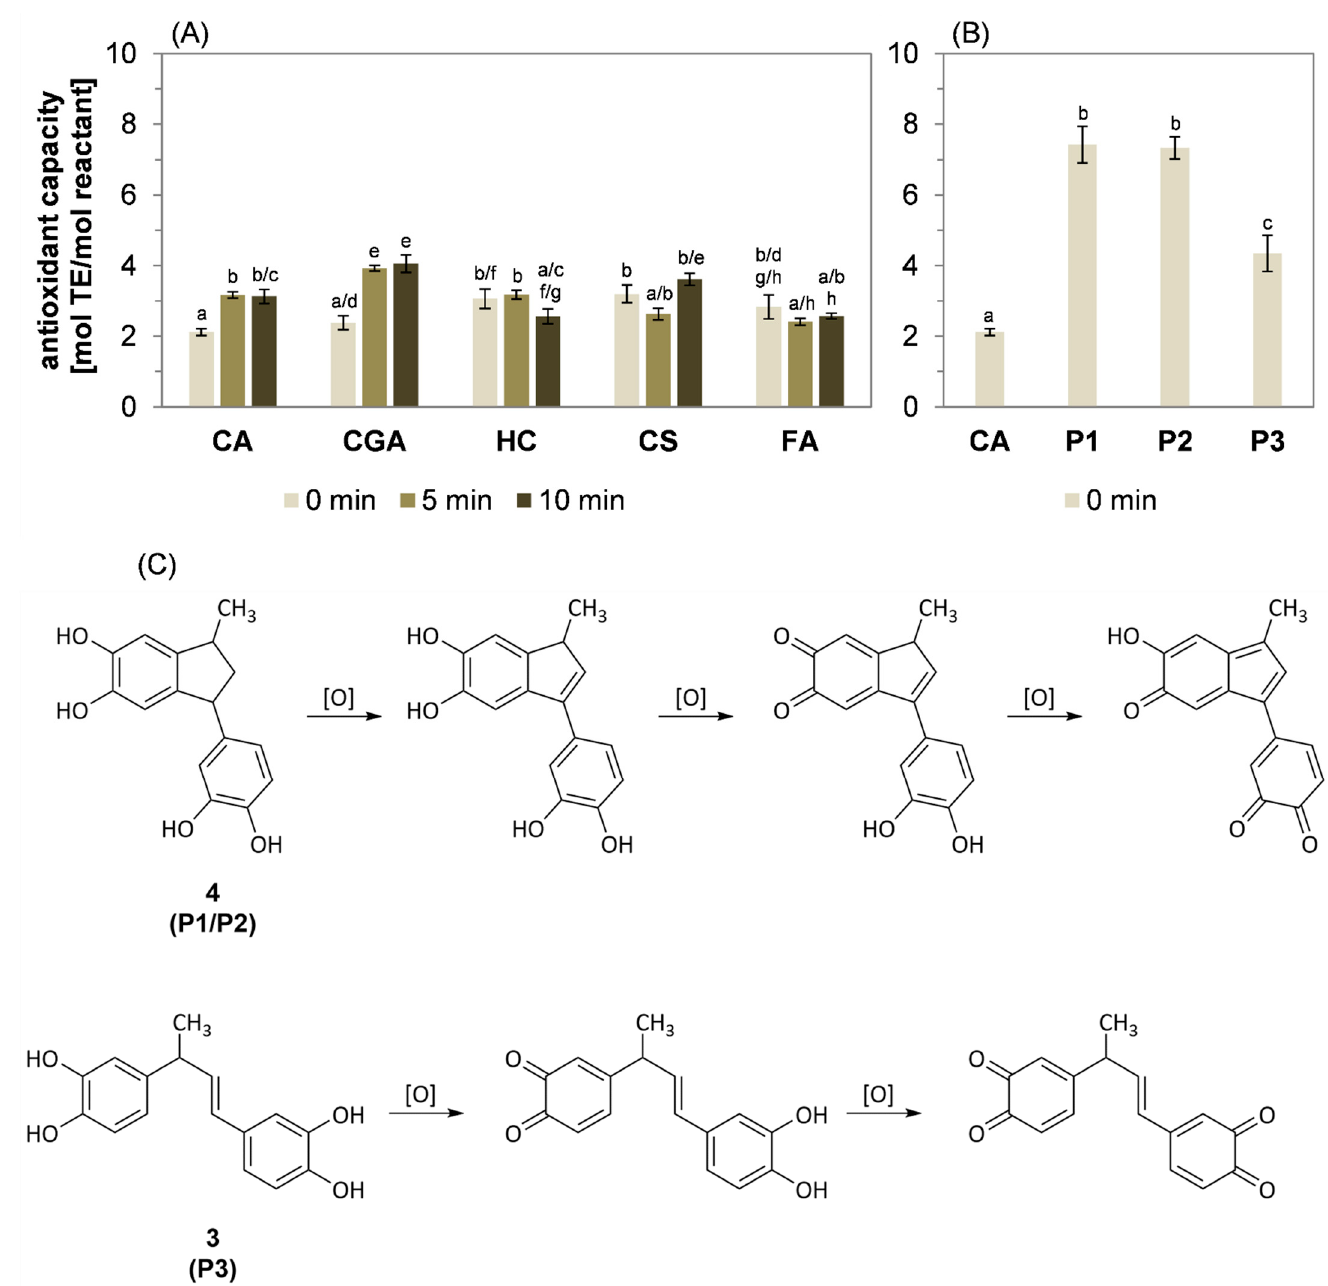
Figure 6. Antioxidant properties of phenolic compounds. ( A ) Antioxidant activity of reaction mixtures of caffeic acid, chlorogenic acid, hydrocaffeic acid, para -coumaric acid, and ferulic acid. ( B ) Antioxidant capacity of caffeic acid and reaction products 3 (P3) and 4 (P1/P2) at 0 min compared to Trolox, given as Trolox equivalents (TE). ( C ) Proposed oxidation reactions of products 3 and 4 . Statistically significant values ( p < 0.05) were analyzed by ( A ) two-way ANOVA and T UKEY ’s test and ( B ) one-way ANOVA and T UKEY ’s test. Statistical differences within the columns are designated by different letters.